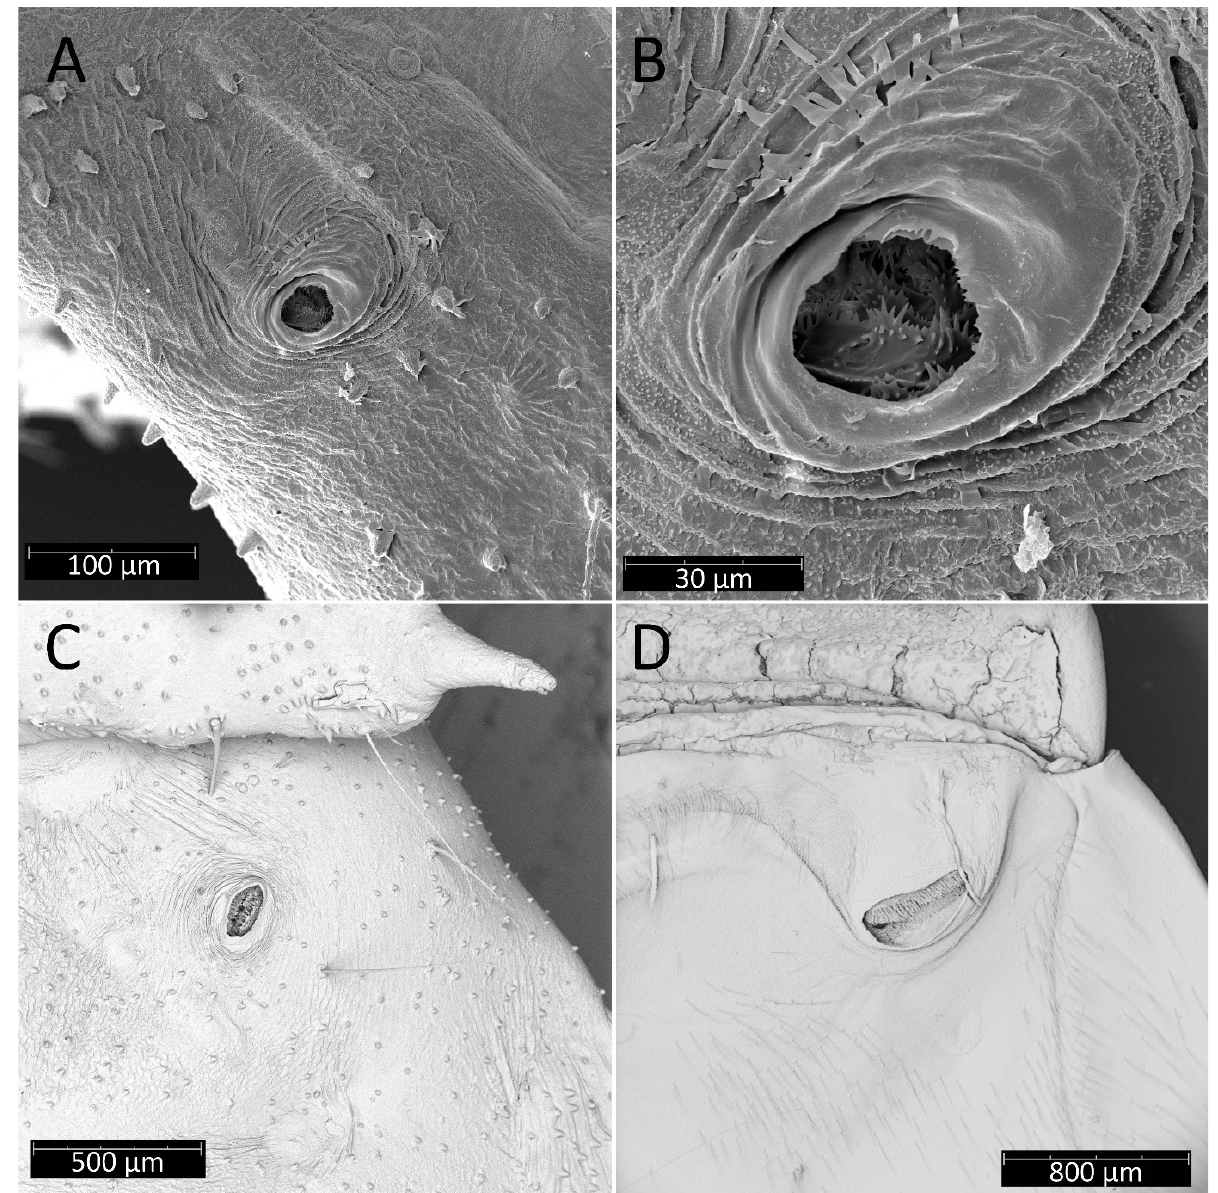
Figure 23. Spiracles on the dorsal side of the first abdominal segment of Psyttala horrida (Stål, 1865): ( A ) second instar; ( B ) magnification of the interior; ( C ) fourth instar; ( D ) adult.